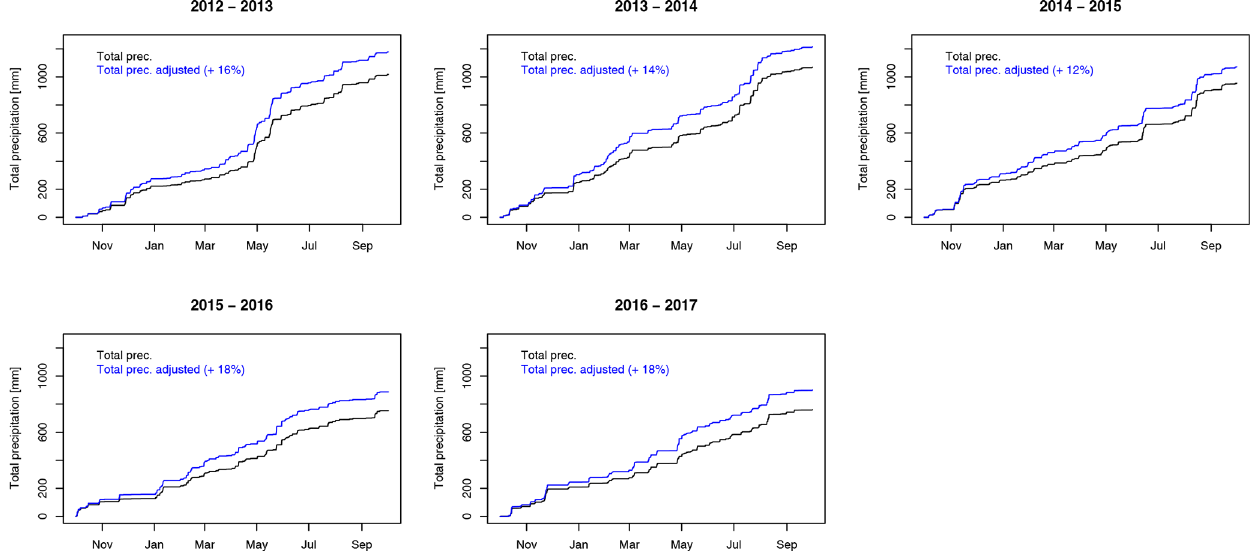
Figure A1. Cumulated total precipitation at the Torgnon site measured by the OTT Pluvio2 precipitation gauge (black) compared to the precipitation adjusted with the method of Kochendorfer et al. (2017a) for the five snow seasons considered (blue).